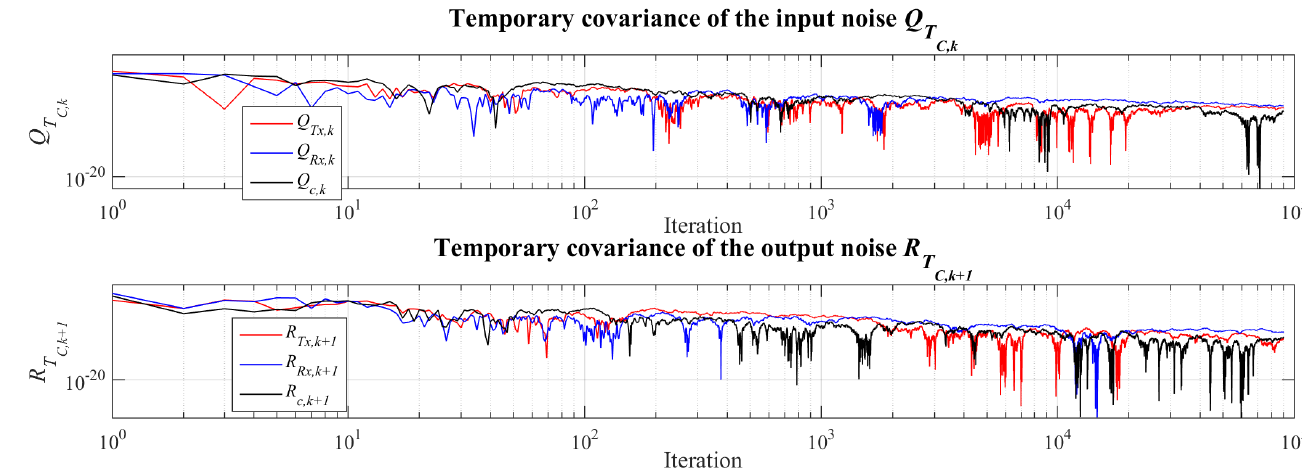
Figure 10. Temporary behavior of covariances Q T Table 1. Temporary covariance values of the input noises Q T